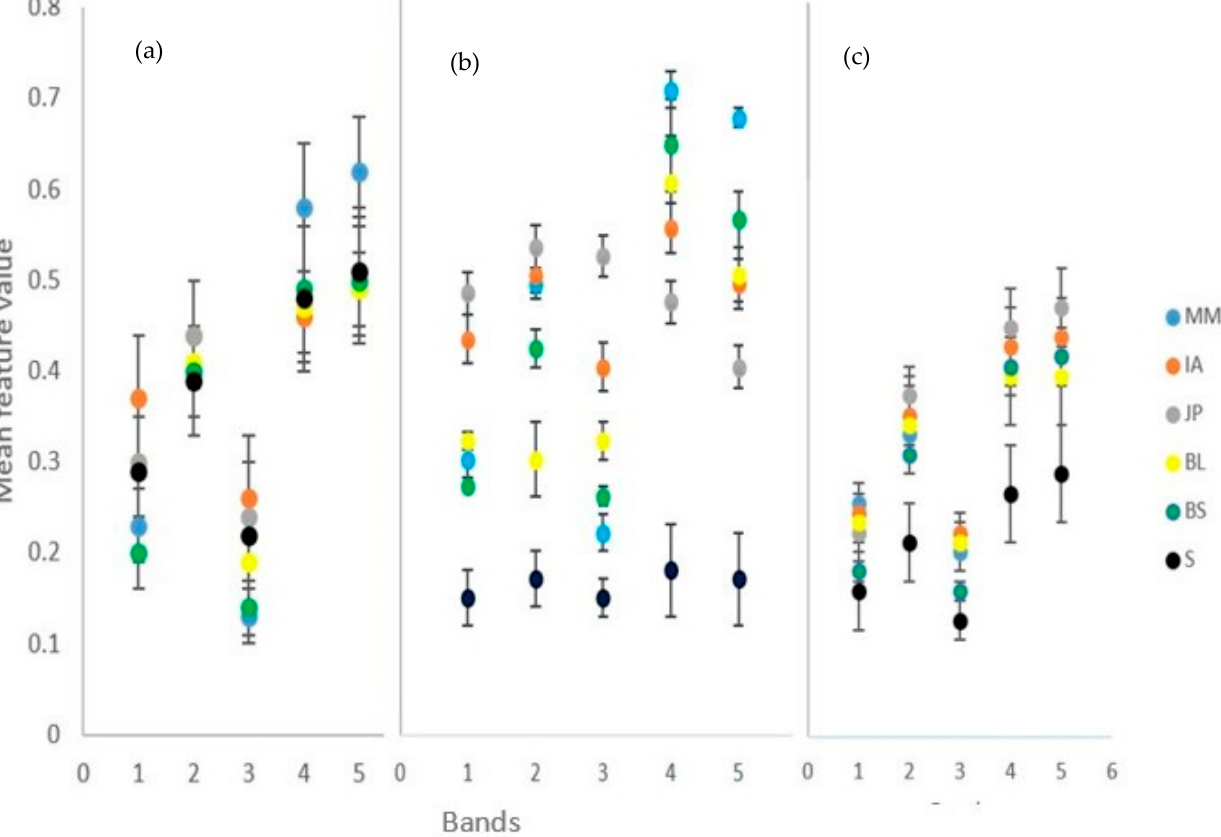
Figure 5. Species separability in different bands (1, blue; 2, green; 3, red; 4, red-edge; 5, near infrared): ( a ) 25.05.21 image, ( b ) 15.08.21 image; and ( c ) 24.10.21 image. S = shadow.